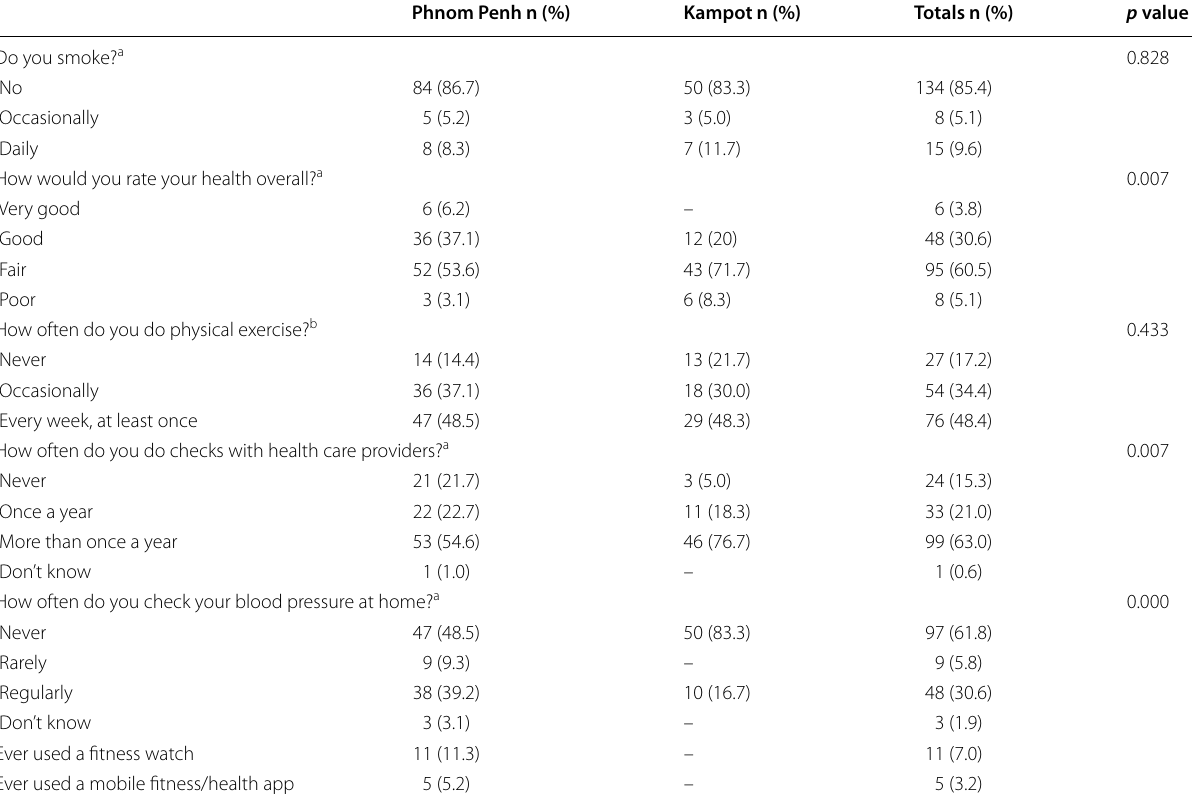
Table 2 Self-reported health and health seeking